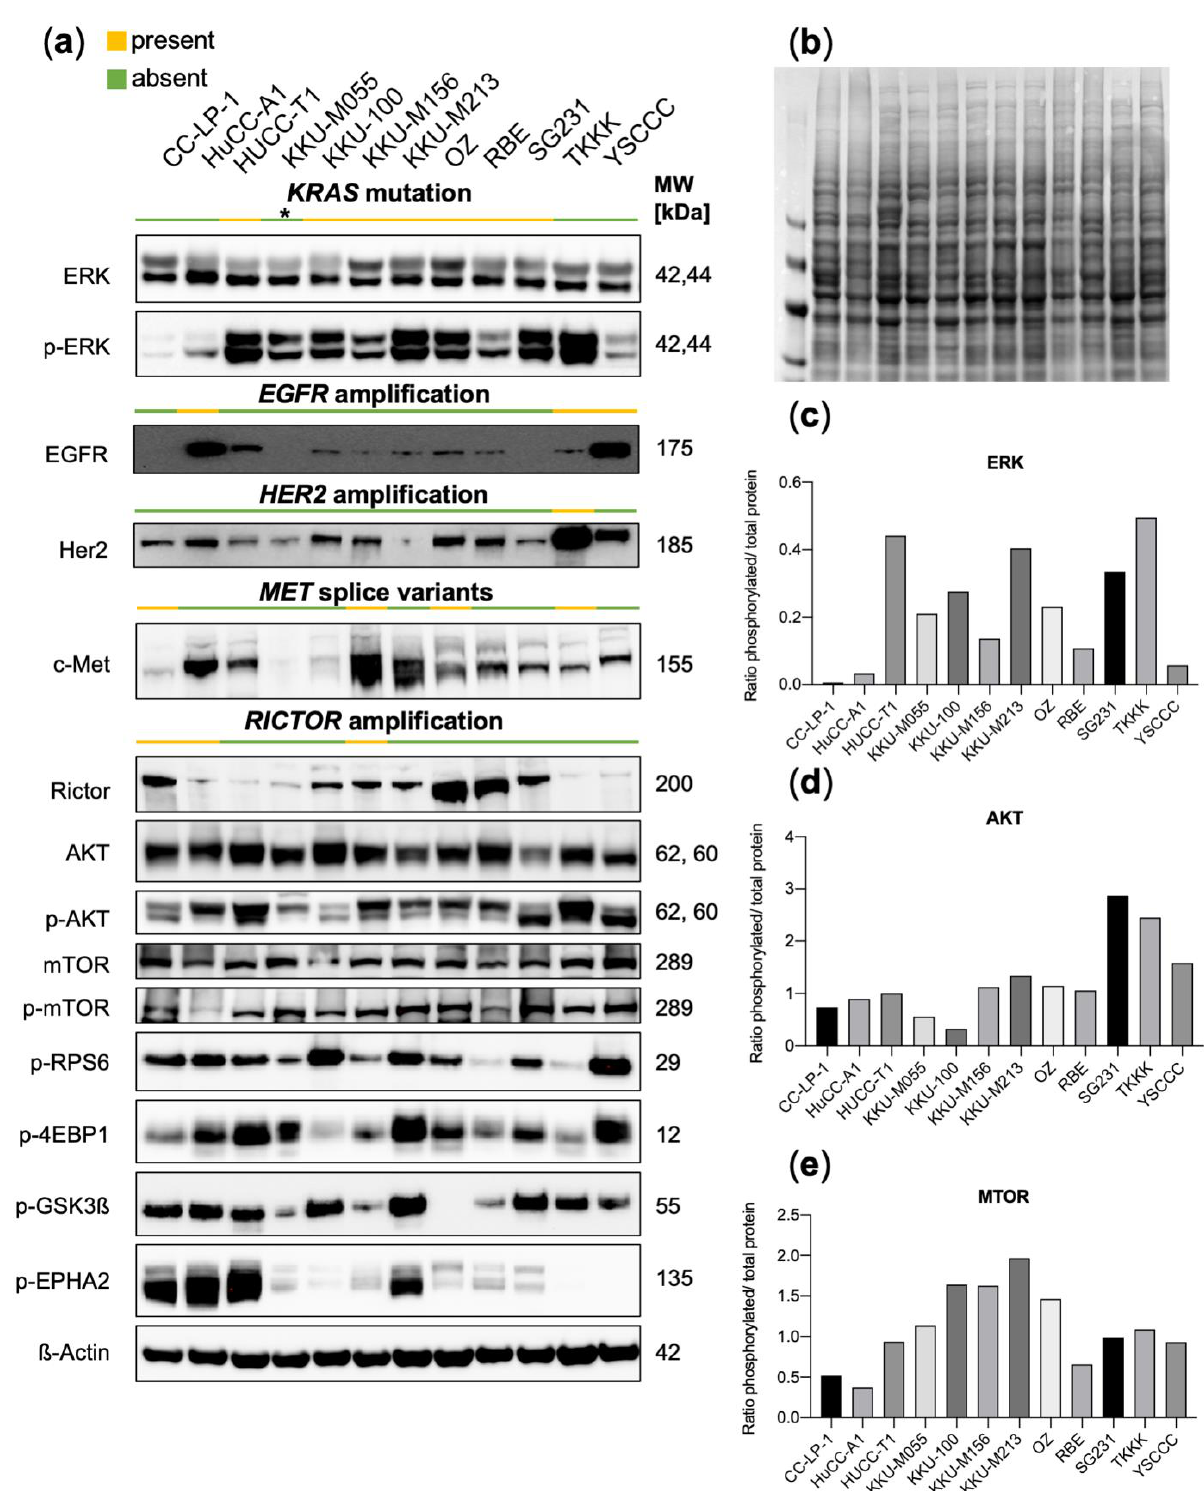
Figure 2. ( a ) Western Blot analyses of 12 CCA cell lines, including effectors of the RAS-MAPK and PI3K-MTOR pathways with the indication of corresponding alteration status. Asterisk indicates that KKUM055 harbors another MAPK-pathway alteration, which is MAP2K1 (p.K57T). ( b ) Ponceau S staining of a representative membrane showing equal protein loading as in ( a ). ( c ) Quantification of band intensity ratios [phosphorylated (p)/ total protein levels] for ERK, ( d ) AKT, and ( e ) MTOR. No technical or experimental repeats of Western Blots were performed ( n = 1). MW, molecular weight.